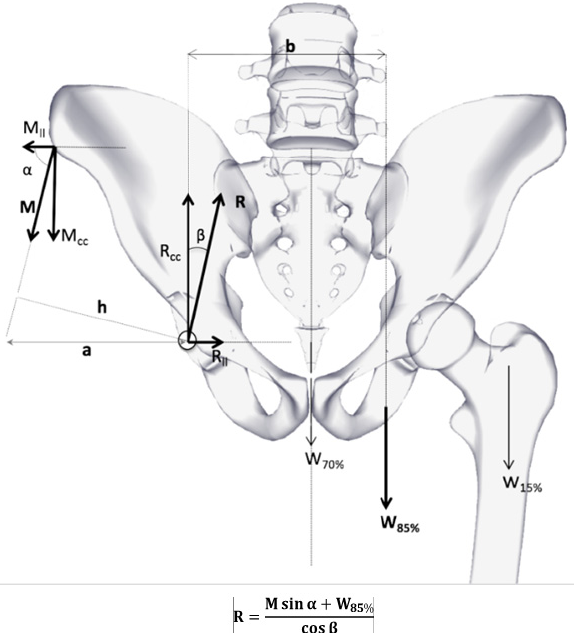
Figure 4. Biomechanics diagram of forces over hip (anteroposterior view). Main vectors are M (me- dial gluteus muscle) and R (total force over the hip joint).